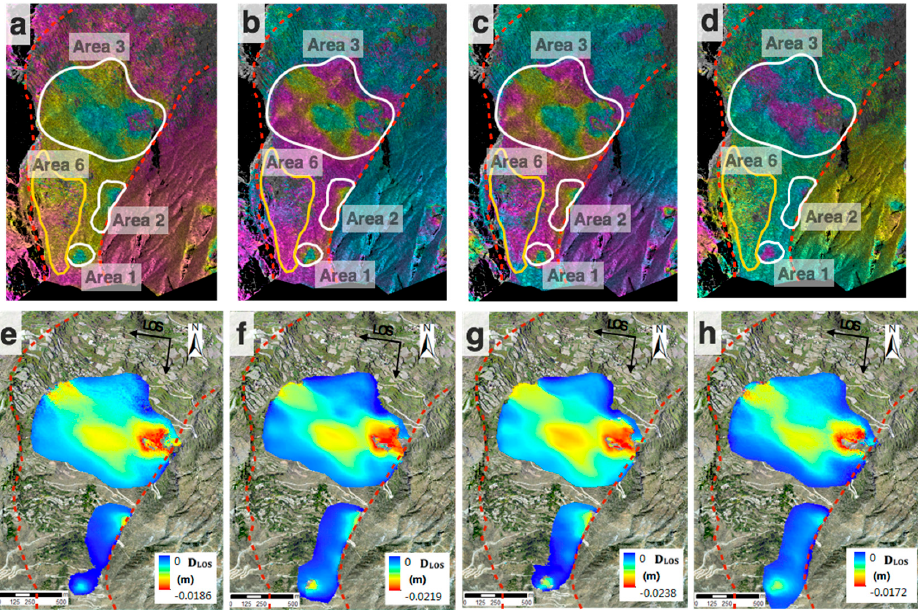
Figure 4. Geocoded differential interferograms ( a – d ) and geocoded displacement maps ( e – h ) in the LOS direction with temporal baselines and perpendicular baselines noted below. Significant landslide displacement signals are highlighted with white ellipses in the interferograms, which also correspond to Areas 1–3 in Figure 2; ( a , e ) 21 November 2014–13 December 2014 (22 days, 54 m);